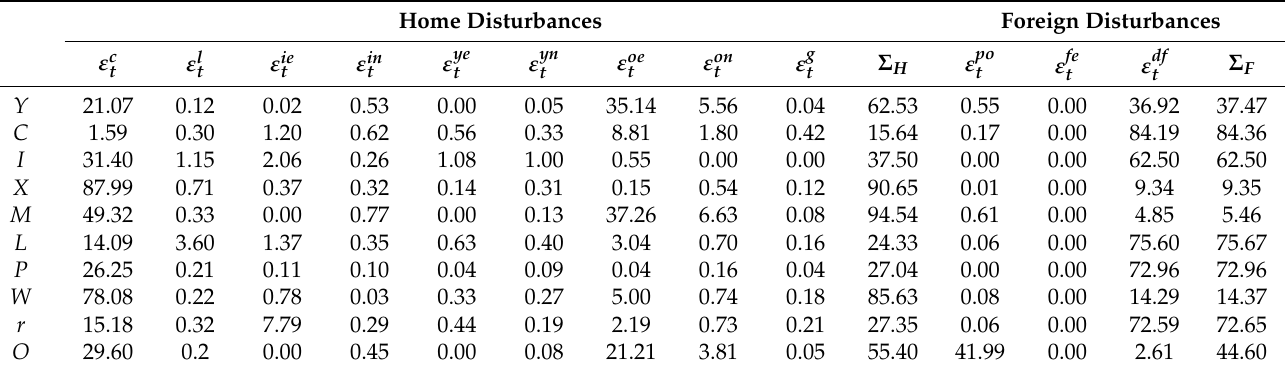
Table 5. Variance decomposition for macroeconomic